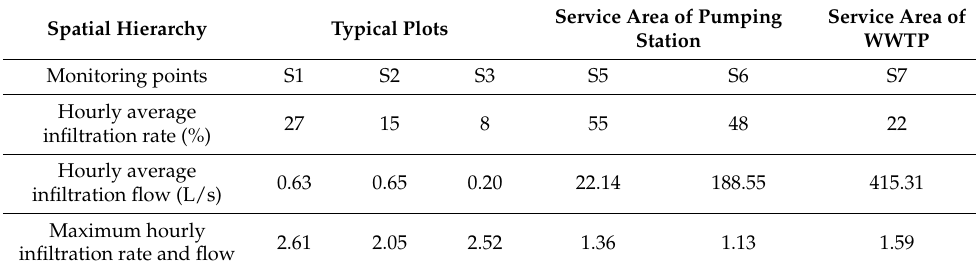
Table 2. Statistics result of sewage network hourly infiltration rate on dry days.